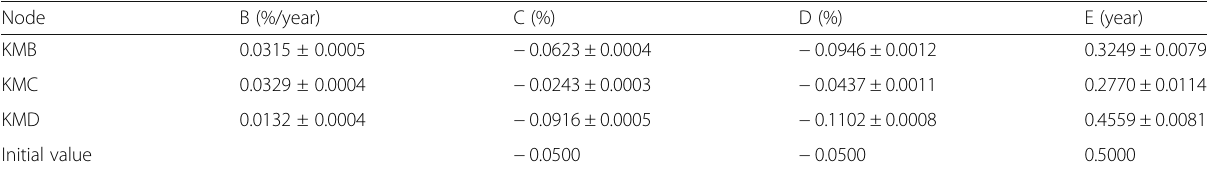
Table 1 Parameters of the best-fitting curves to observed seismic velocity changes. Initial values used in non-linear regression are also listed